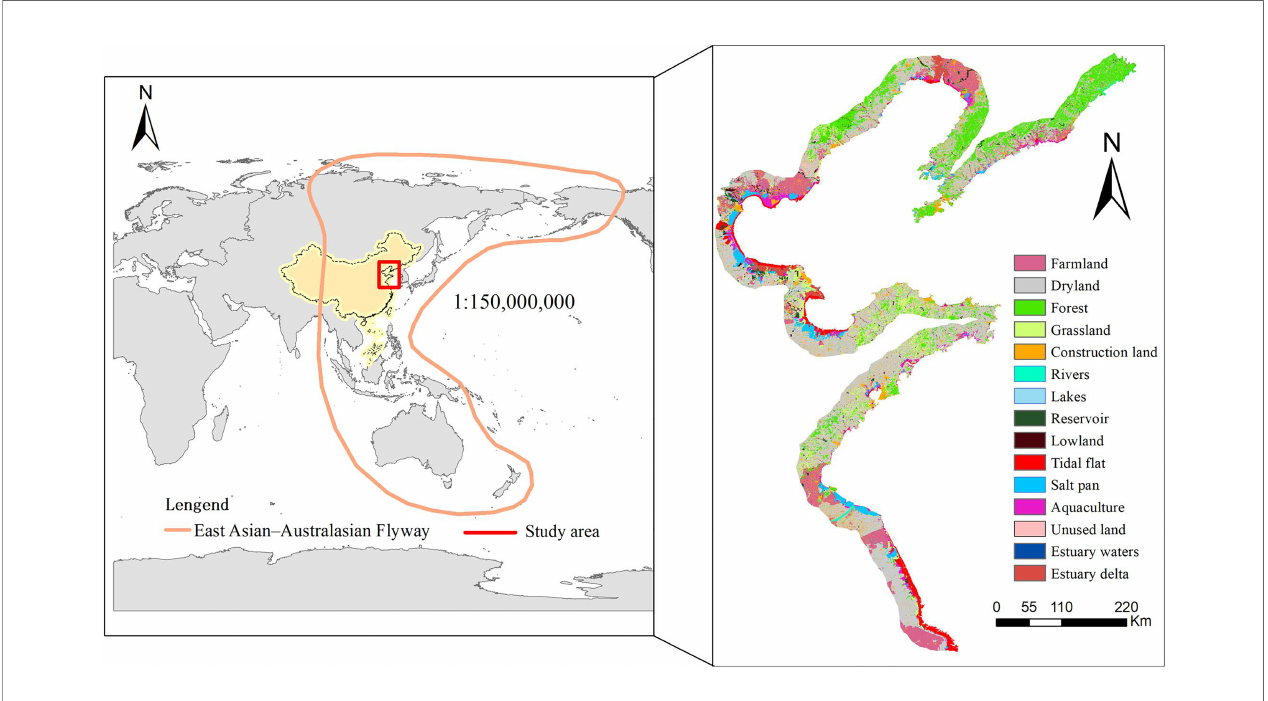
FIGURE 1 | Study area in the Yellow Sea and Bohai Sea,